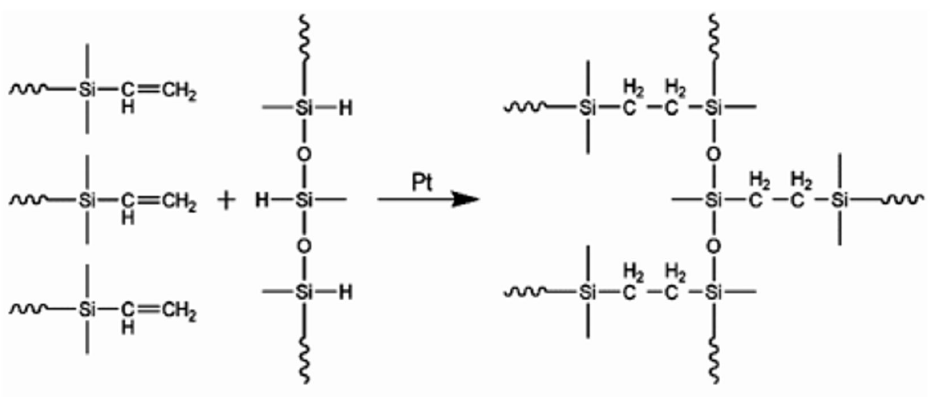
Figure 2. Cross-linking chemistries for silicone elastomer by hydrosilylation